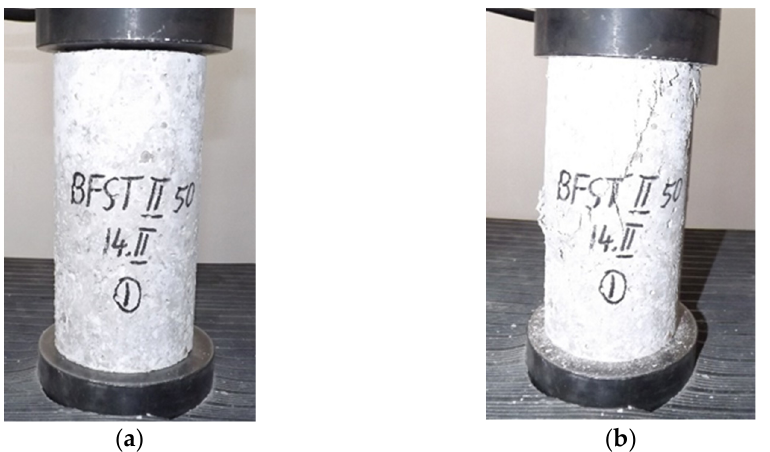
Figure 2. Concrete compressive strength testing. ( a ) Positioning of the test specimen; ( b ) compressive crack, after performing the test.